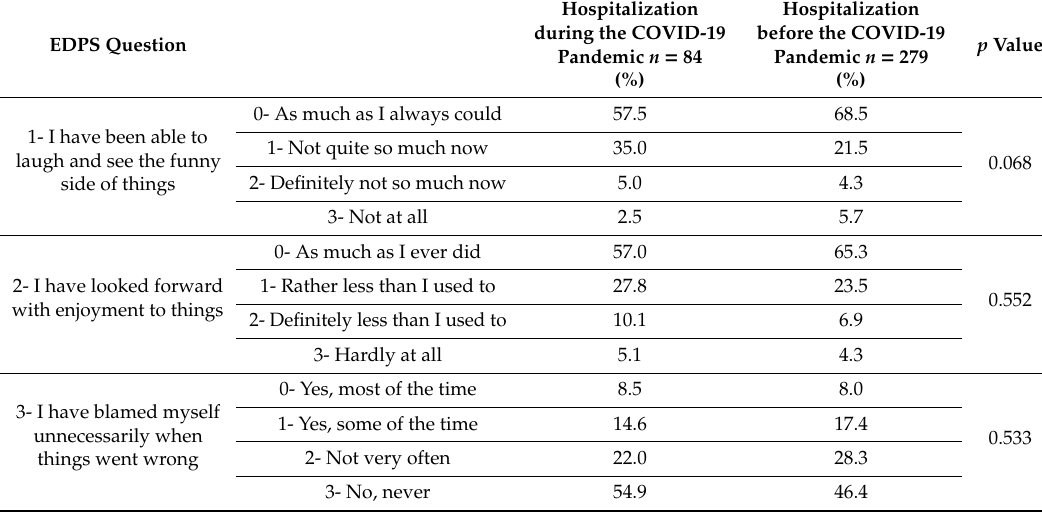
Table 2. Scores of the EDPS questions, among women hospitalized in the high-risk pregnancy units during and before the COVID-19